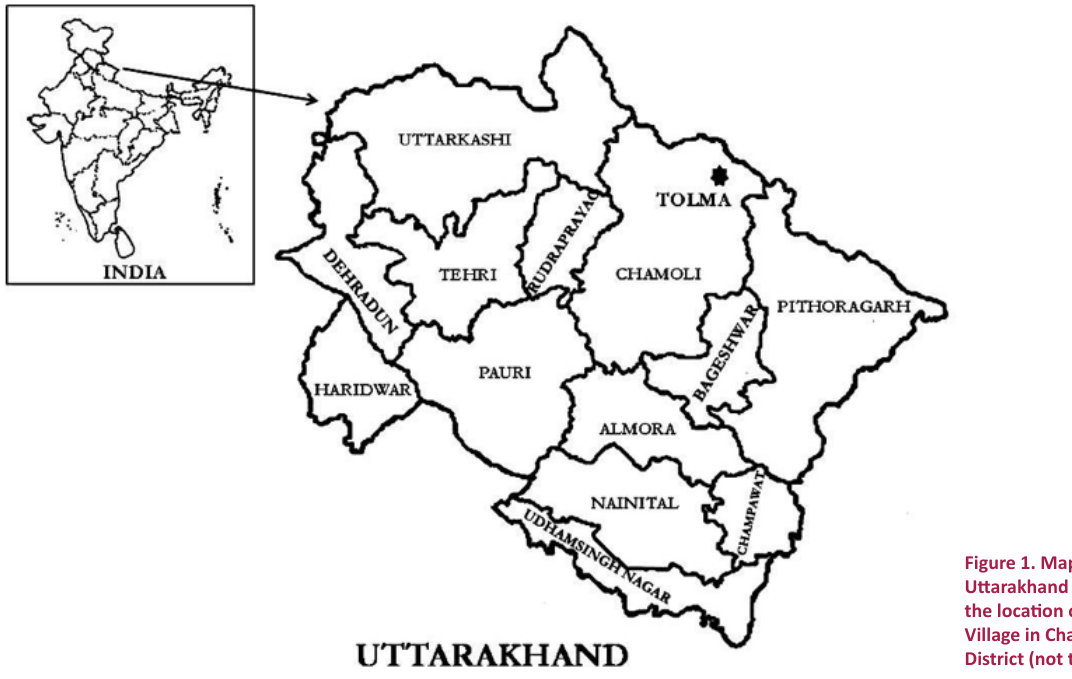
Figure 1. Map of Uttarakhand showing the location of Tolma Village in Chamoli District (not to